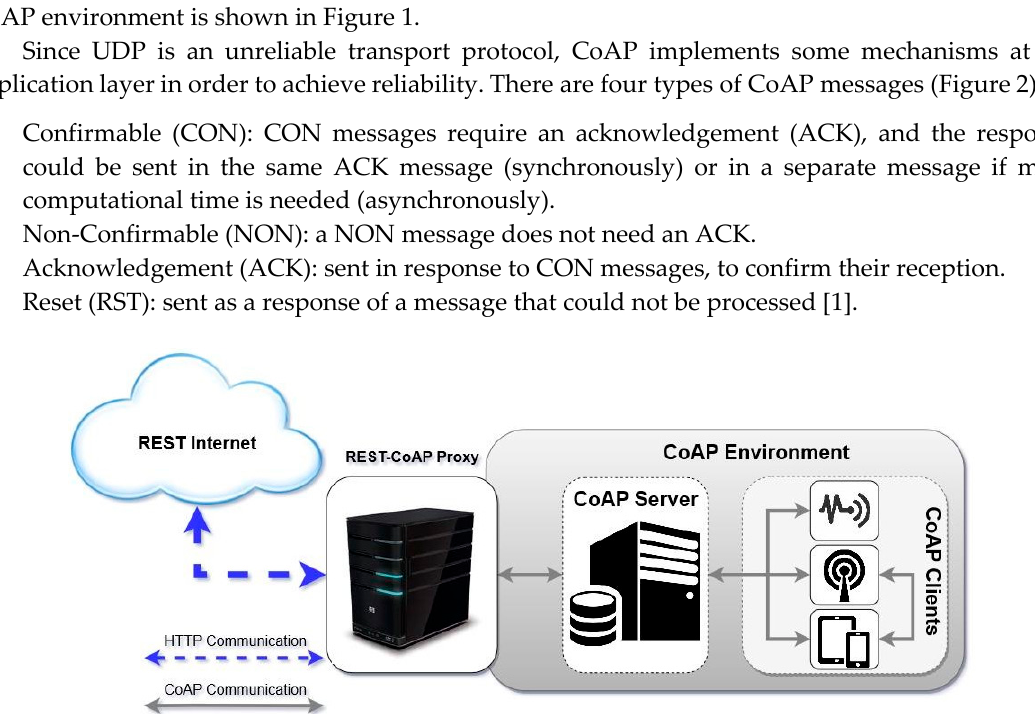
Figure 1. Client/Server model protocol in a Constrained Application Protocol (CoAP)